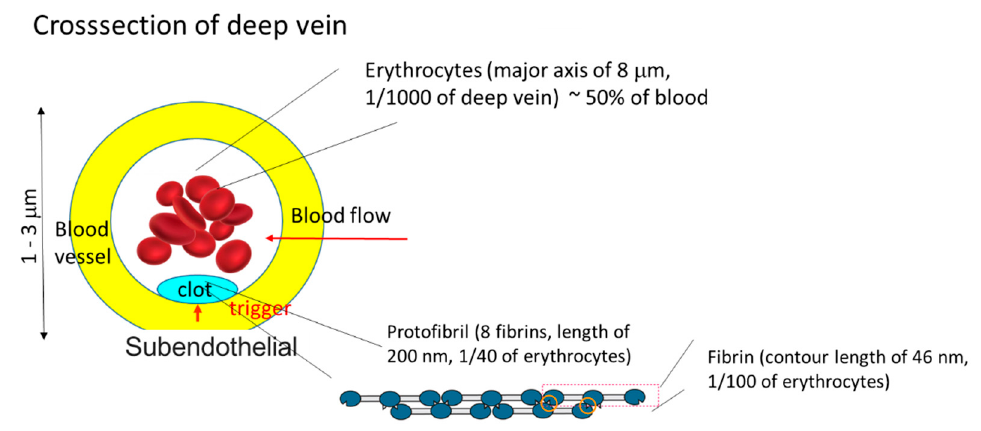
Figure 4. Illustration of blood coagulation at blood vessel wall.